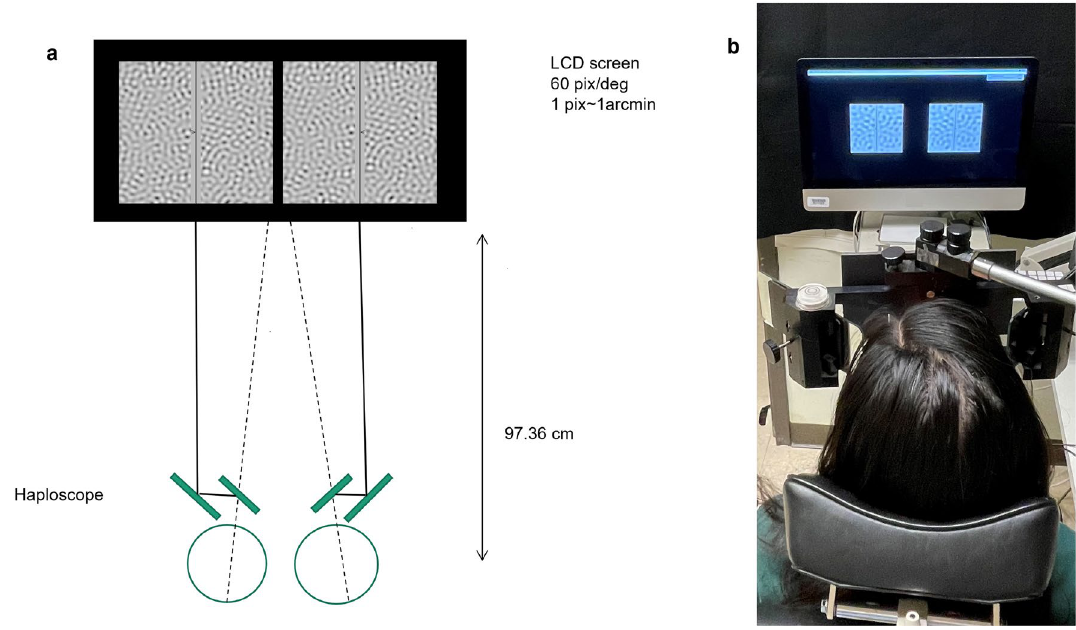
Figure 7. ( a ) Schematic diagram of the experimental setup, figure is not drawn to scale. ( b ) Subject viewing stimuli through the haploscope on a monitor screen with the head positioned on the head rest. The convergence angle of the eyes was adjusted to match the optical distance to the targets for comfortable fusion. Trials were run in dim room light and the subject’s view was masked off to ensure that each eye saw just one image with a dark